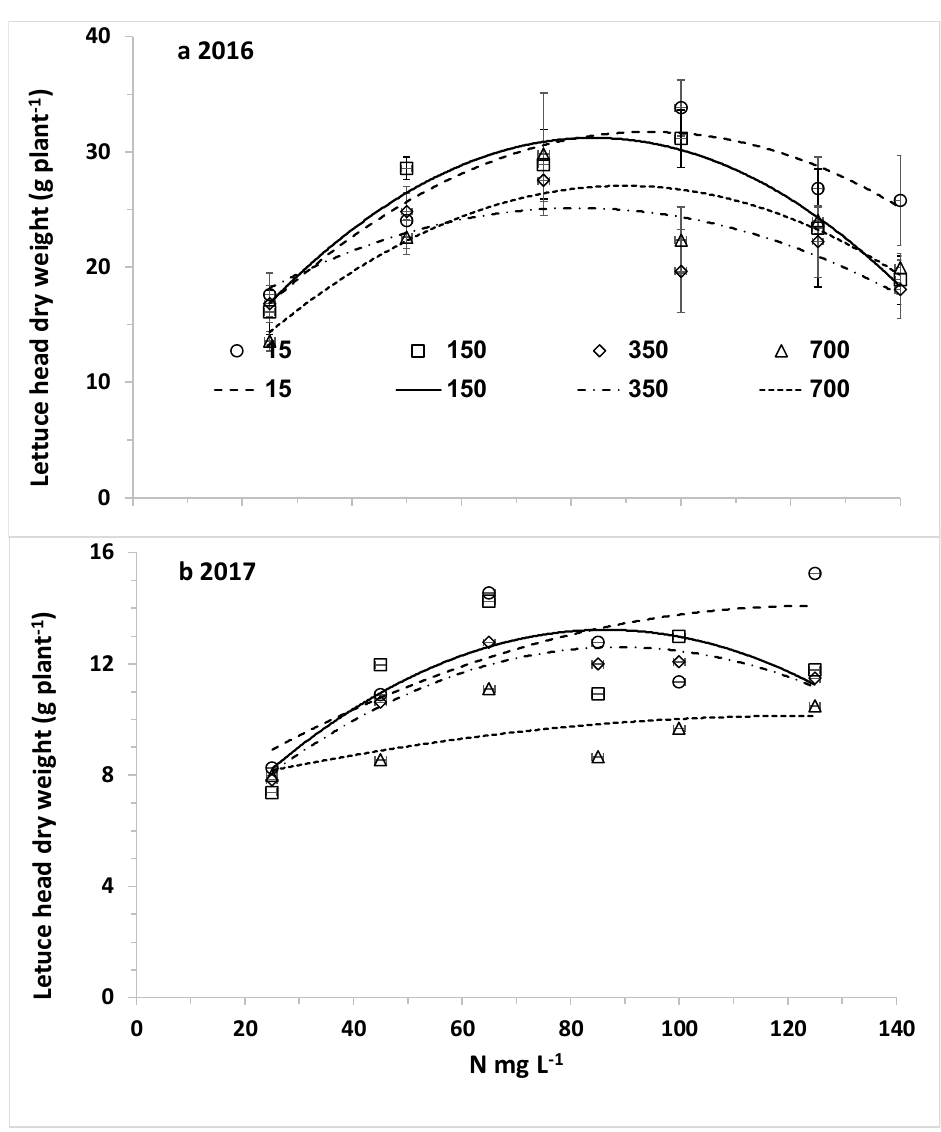
Figure 1. Lettuce head dry weight as a function of N concentration in the irrigating solution at different Cl concentrations in the irrigating solution ( a ) first experiment on 26 September 2016 and ( b ) second experiment on 22 October 2017.